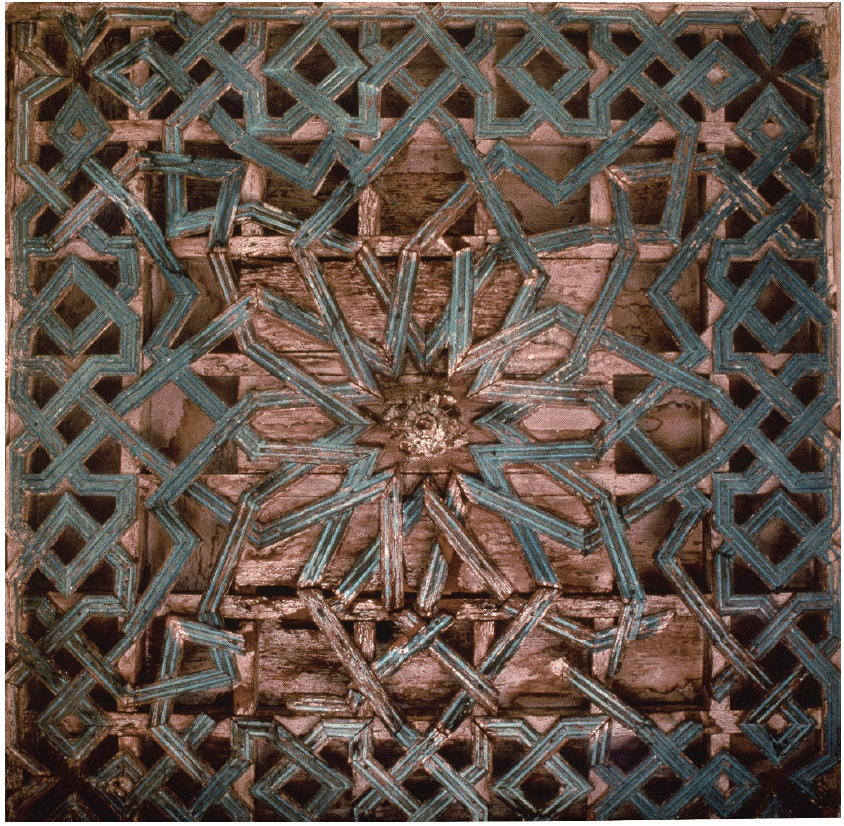
Figure 4. Cloister chapel’s ceiling of Santa Ana convent. Tzintzuntzan. Photo took by author.